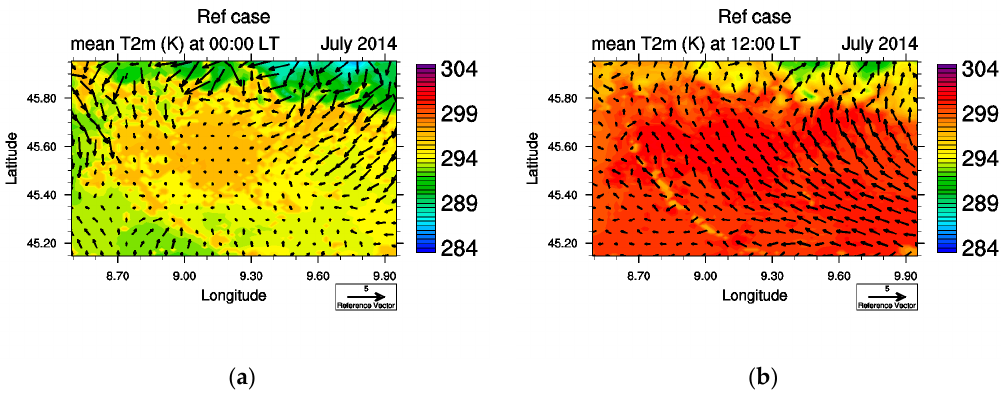
Figure 2. Maps of mean 2m Temperature (°C) over the highest resolution domain for the reference case averaged over the simulation period (14–23 July 2014) ( a ) at 00:00 LT; ( b ) at 12:00 LT. Average wind speed is illustrated by vectors.